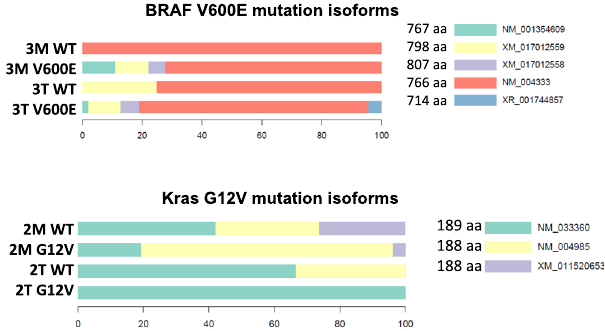
Fig. 4 Mutant isoform switching of BRAF V600E and K-ras G12V in colon cancers. Top panel: Isoform distribution of V600E of BRAF in colon cancer. Bottom panel: Isoform distribution of G12V of KRAS in colon